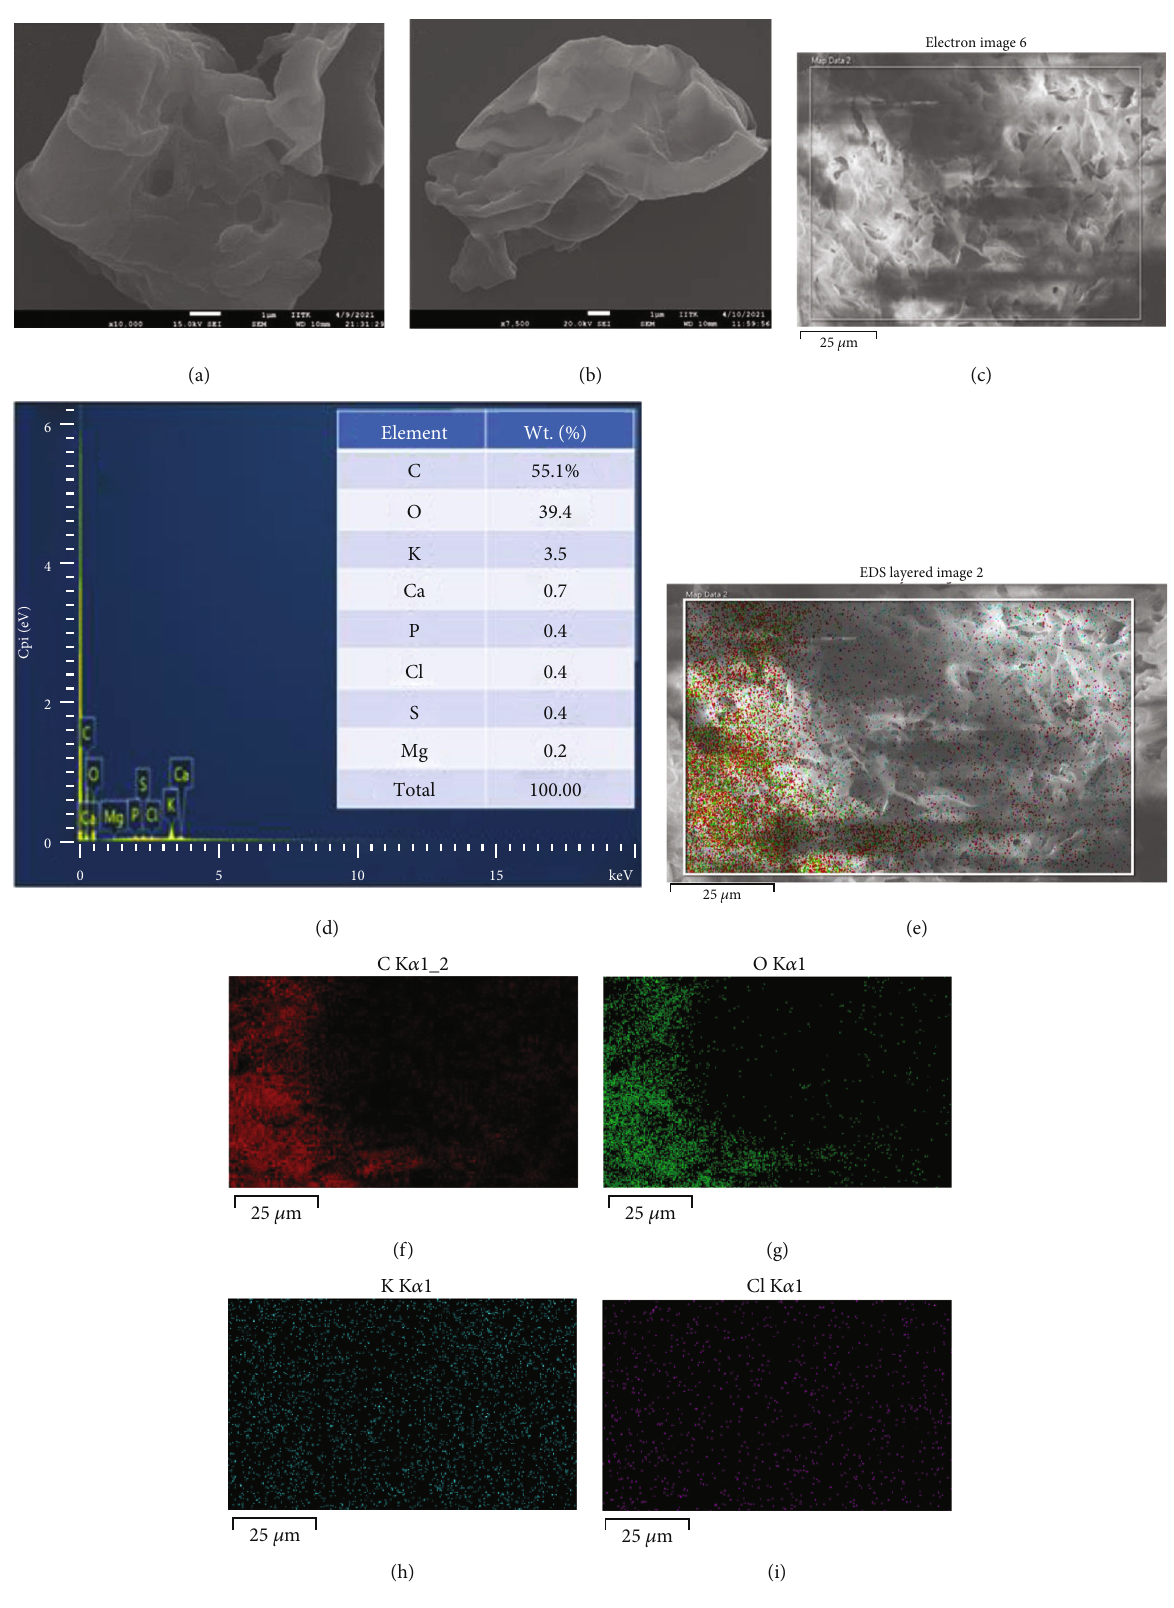
Figure 6: FESEM micrographs of rose petal powder (a, b), EDS spot (c), EDS spectra (d), and elemental mapping of rose powders (e –